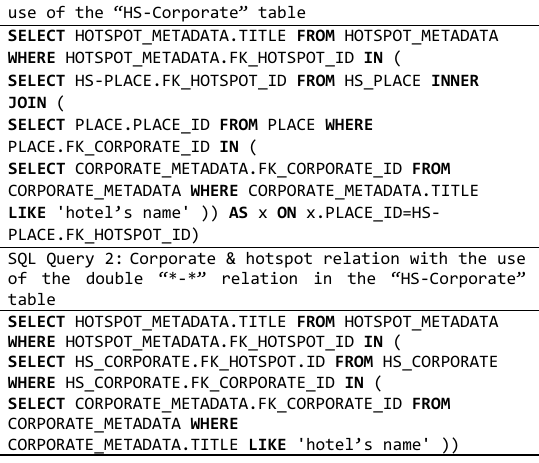
Figure 4. SQL queries for finding hotspots near a hotel